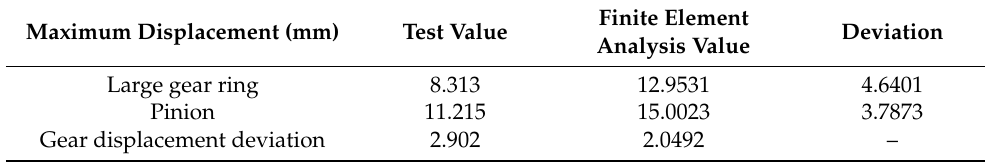
Figure 19. Displacement waveform after secondary integration. Table 3. Pinion gear and large gear ring displacement test values and finite element analysis values.